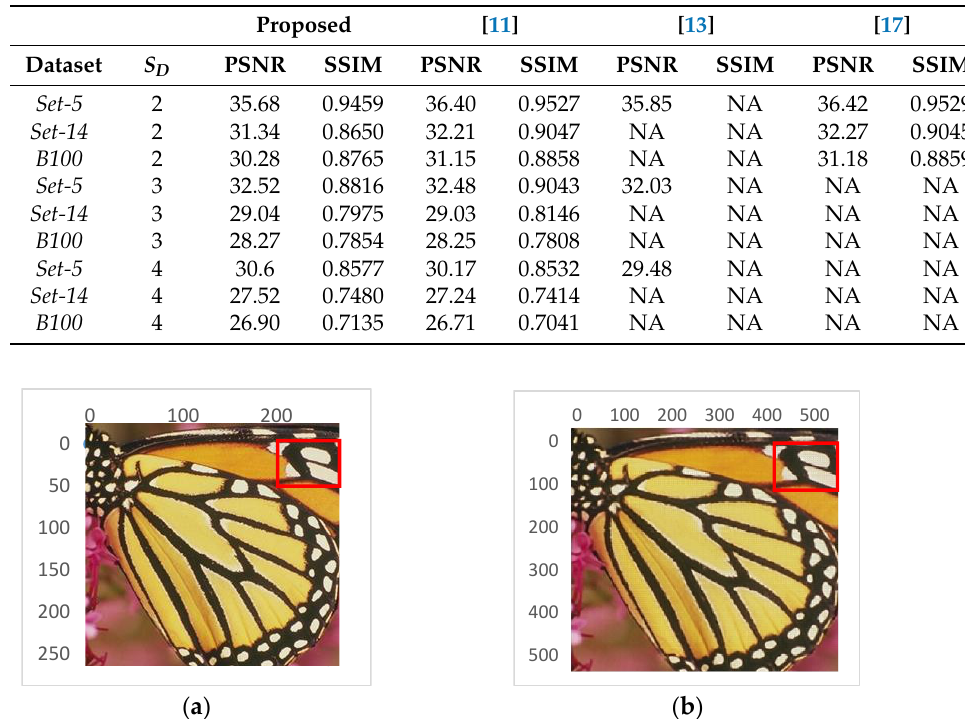
Table 3. Comparison results in terms of the PSNR and SSIM quality metrics.